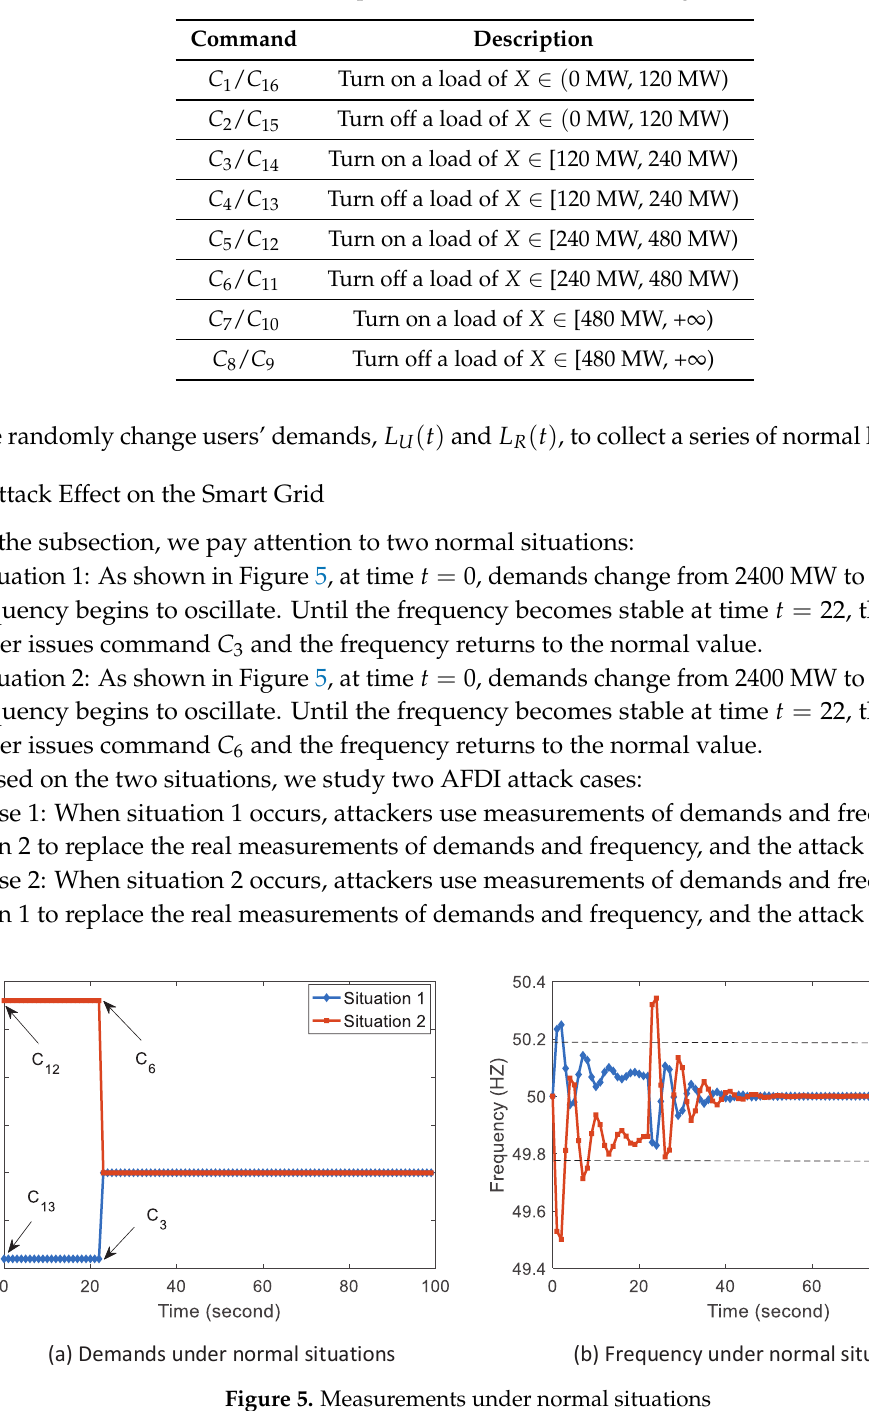
Table 1. Description of commands in the smart grid.